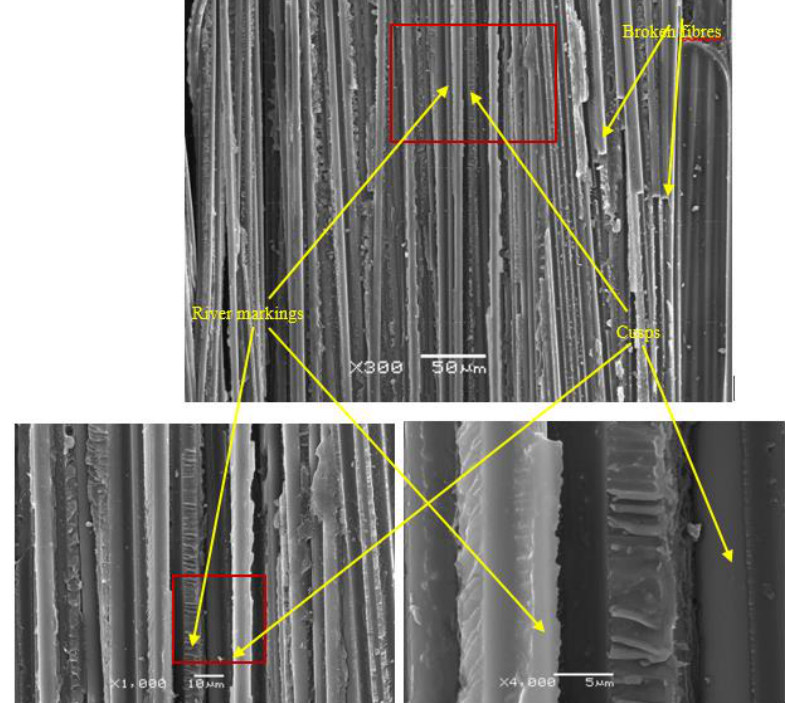
Figure 9. SEM micrographs of a fatigue specimen tested with the MMB device showing the presence of cusps, river markings, and broken fibers.